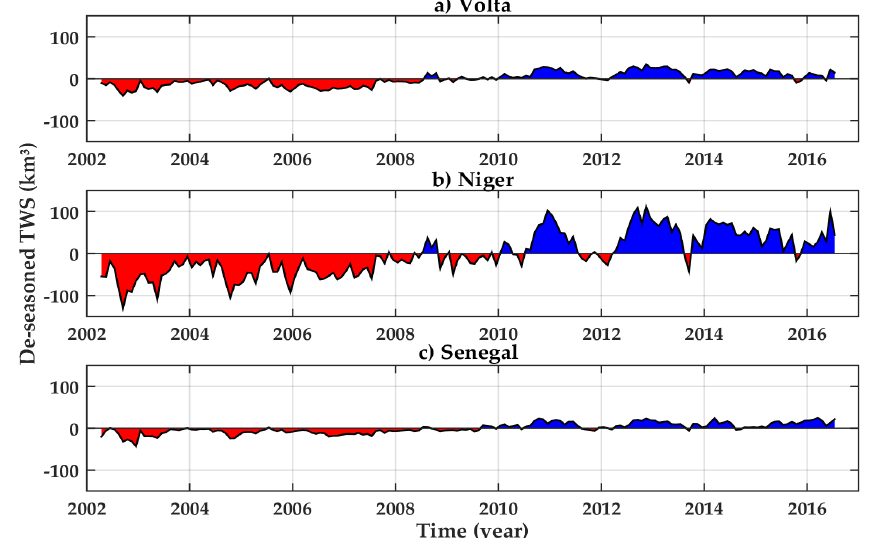
Figure 7. Residual TWS time series (de-seasoned TWS) calculated as the difference between the time series and the climatology for Volta Basin ( a ), Niger Basin ( b ), and Senegal Basin ( c ). These residual time series depict the deviation from the normal annual (climatology) where positive deviations characterize the excess and relatively wet periods represented in the blue area whereas negative residuals relate to relatively dry periods shown in red area.